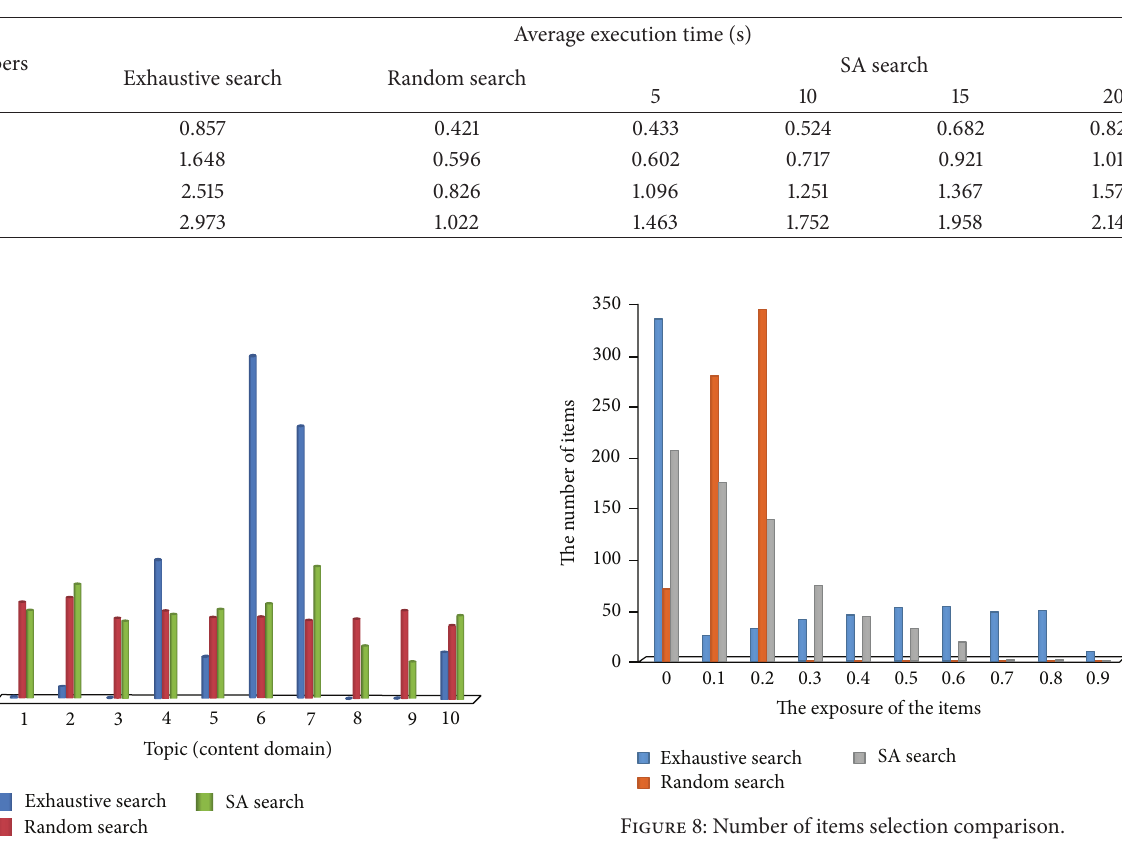
Table 2: The average execution time of the algorithm.